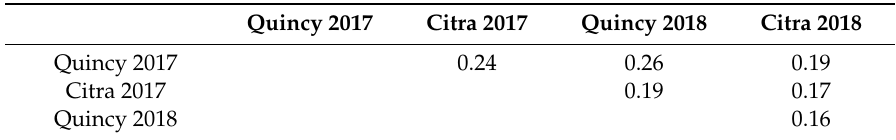
Table 4. Estimates of genetic correlation among four environments averaged over four traits at Citra, FL and Quincy, FL in 2017 and